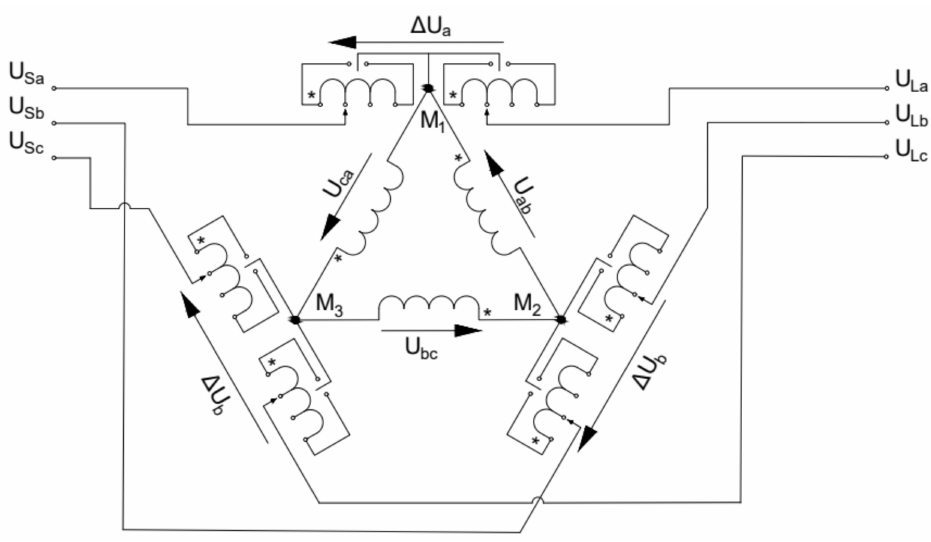
Figure 4. Symmetrical direct PST connection